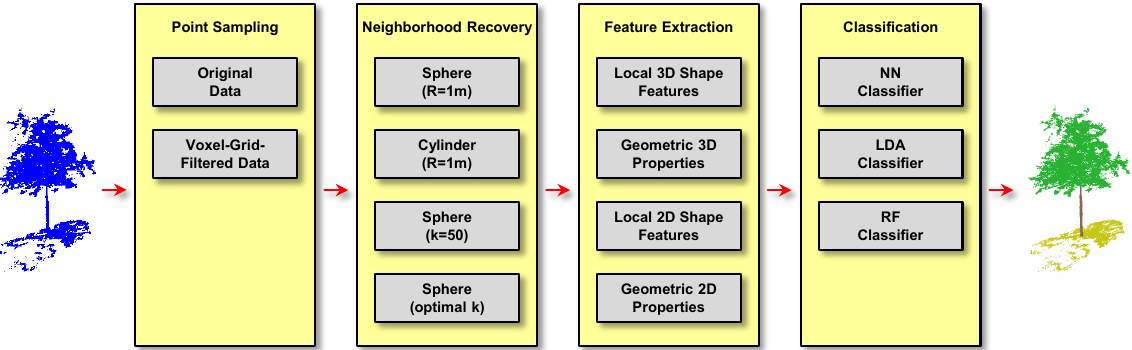
Figure 2. Overview on the proposed methodology: the original point cloud is either kept or downsampled via voxel-grid filtering; local neighborhoods are subsequently recovered to extract geometric features which are provided as input to a classifier; the training data is furthermore used to assess feature relevance with respect to the given classification